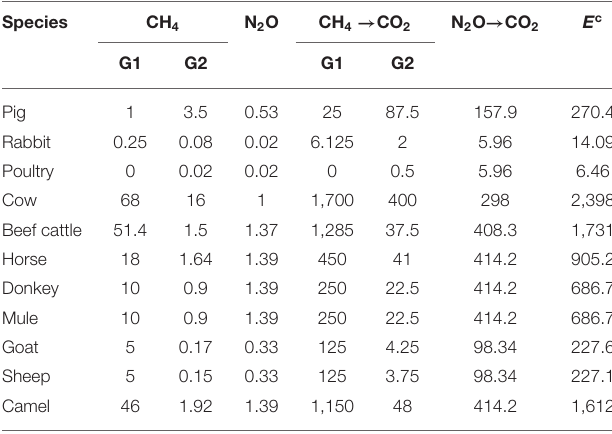
TABLE 1 | Carbon emissions coefficient of animal husbandry in China (unit: Kg/head/year).